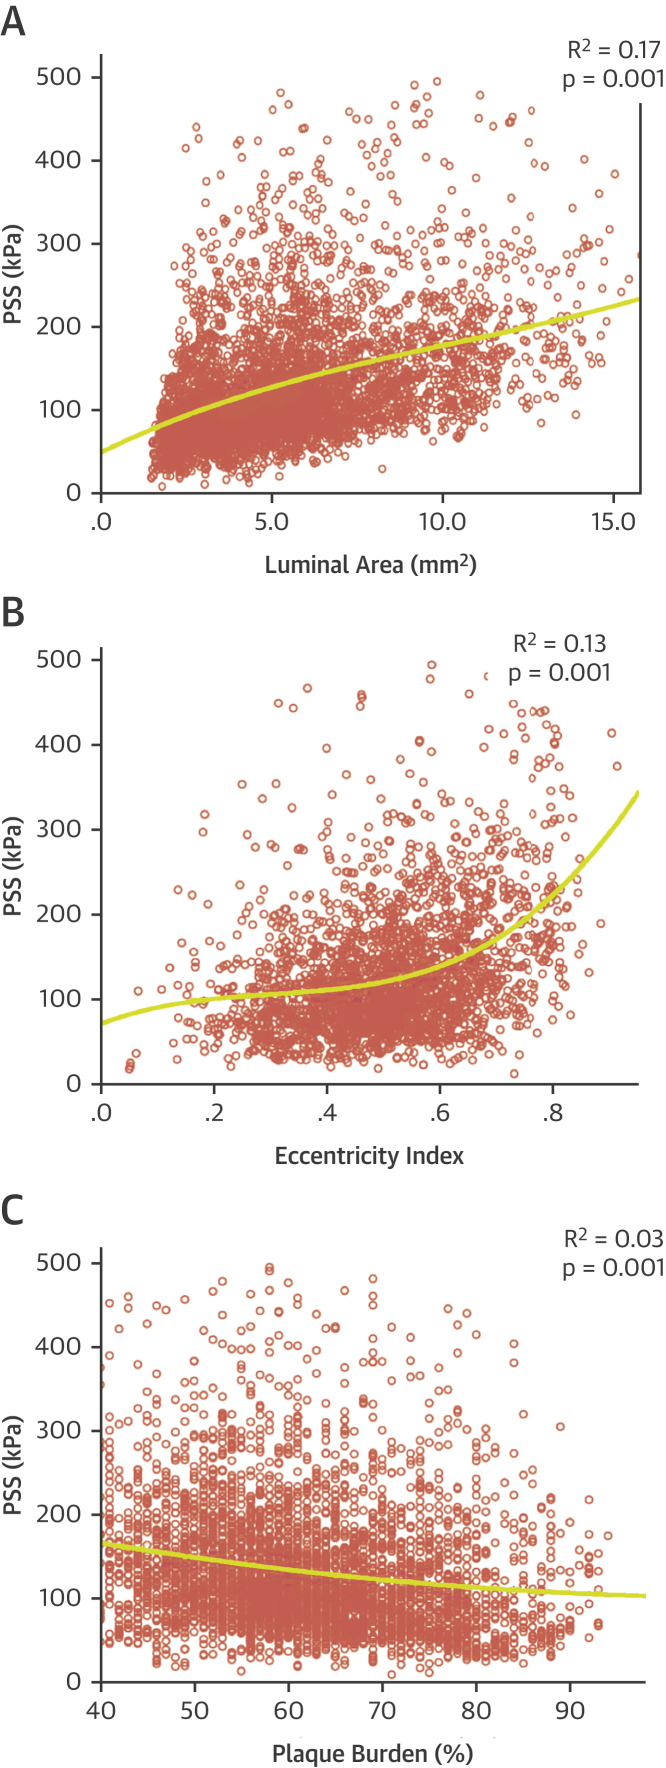
Indices of Vessel Geometry and Plaque Structural Stress(A to C) Regression curves illustrating best-fit relationships between PSS and (A) luminal area, (B) luminal eccentricity or (C) plaque burden. PSS = plaque structural stress.